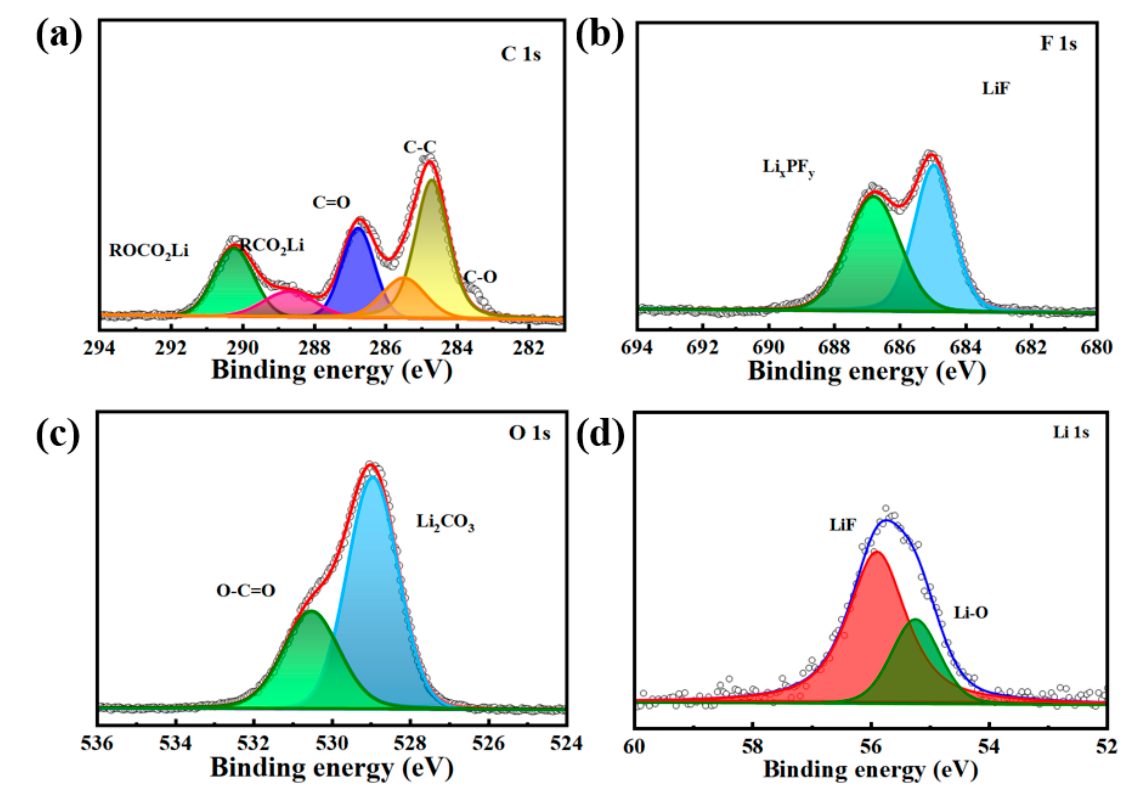
Figure 9. XPS analysis of graphite anode after three cycles in RCE electrolyte: ( a ) C 1s, ( b ) F 1s, ( c ) O 1s, ( d ) Li 1s.